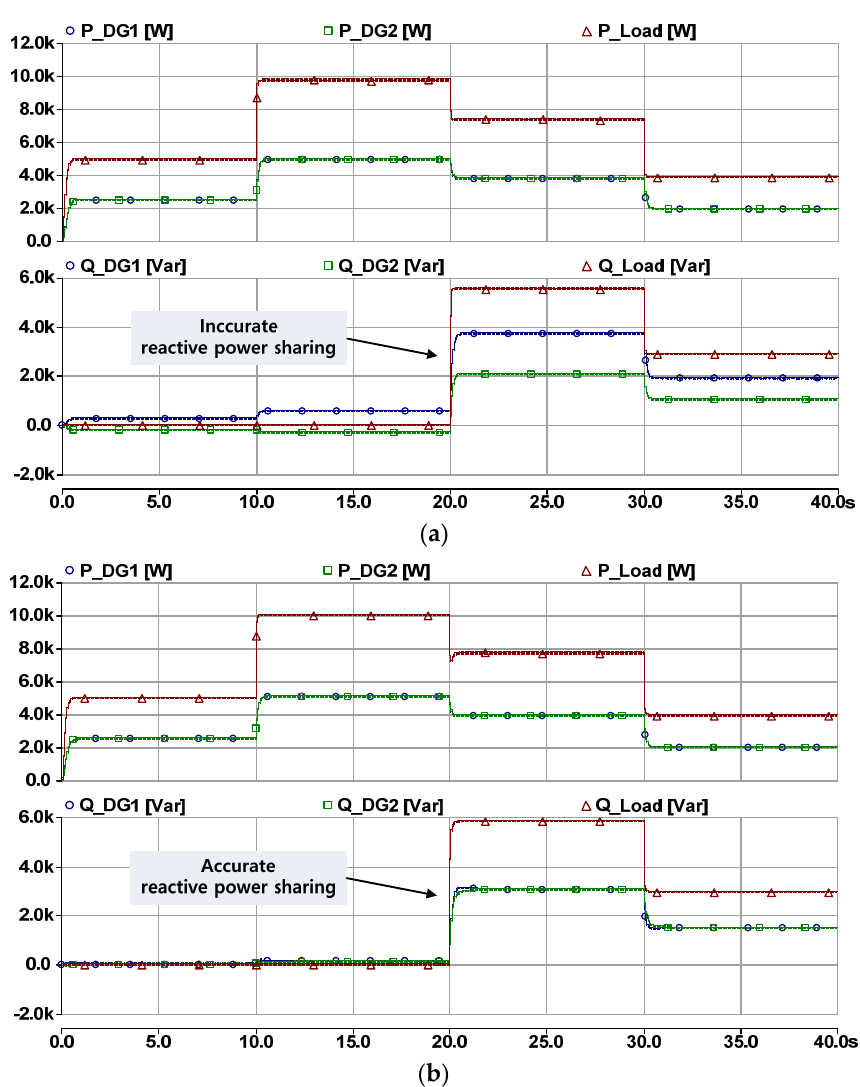
Figure 16. Simulation Results of Active and Reactive Power Sharing for Case 2: ( a ) Existing droop ( b ) Proposed droop.